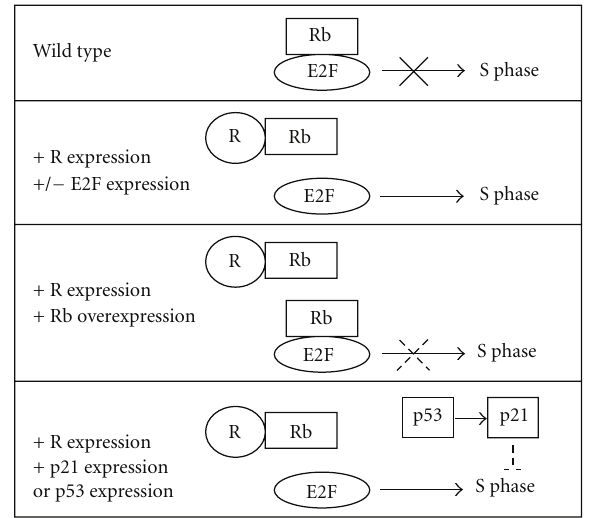
Figure 8: Model of R’s e ff ect upon S phase entry. Unless given a signal, cells will have Rb bound to E2F to inhibit E2F activity. R protein binds to Rb, displacing it from E2F, in which case E2F will promote S phase entry. Overexpression of E2F enhances this e ff ect. Overexpression of Rb allows for renewed E2F inhibition. p53 or p21 overexpression inhibits cell cycle progression after it is initiated by active